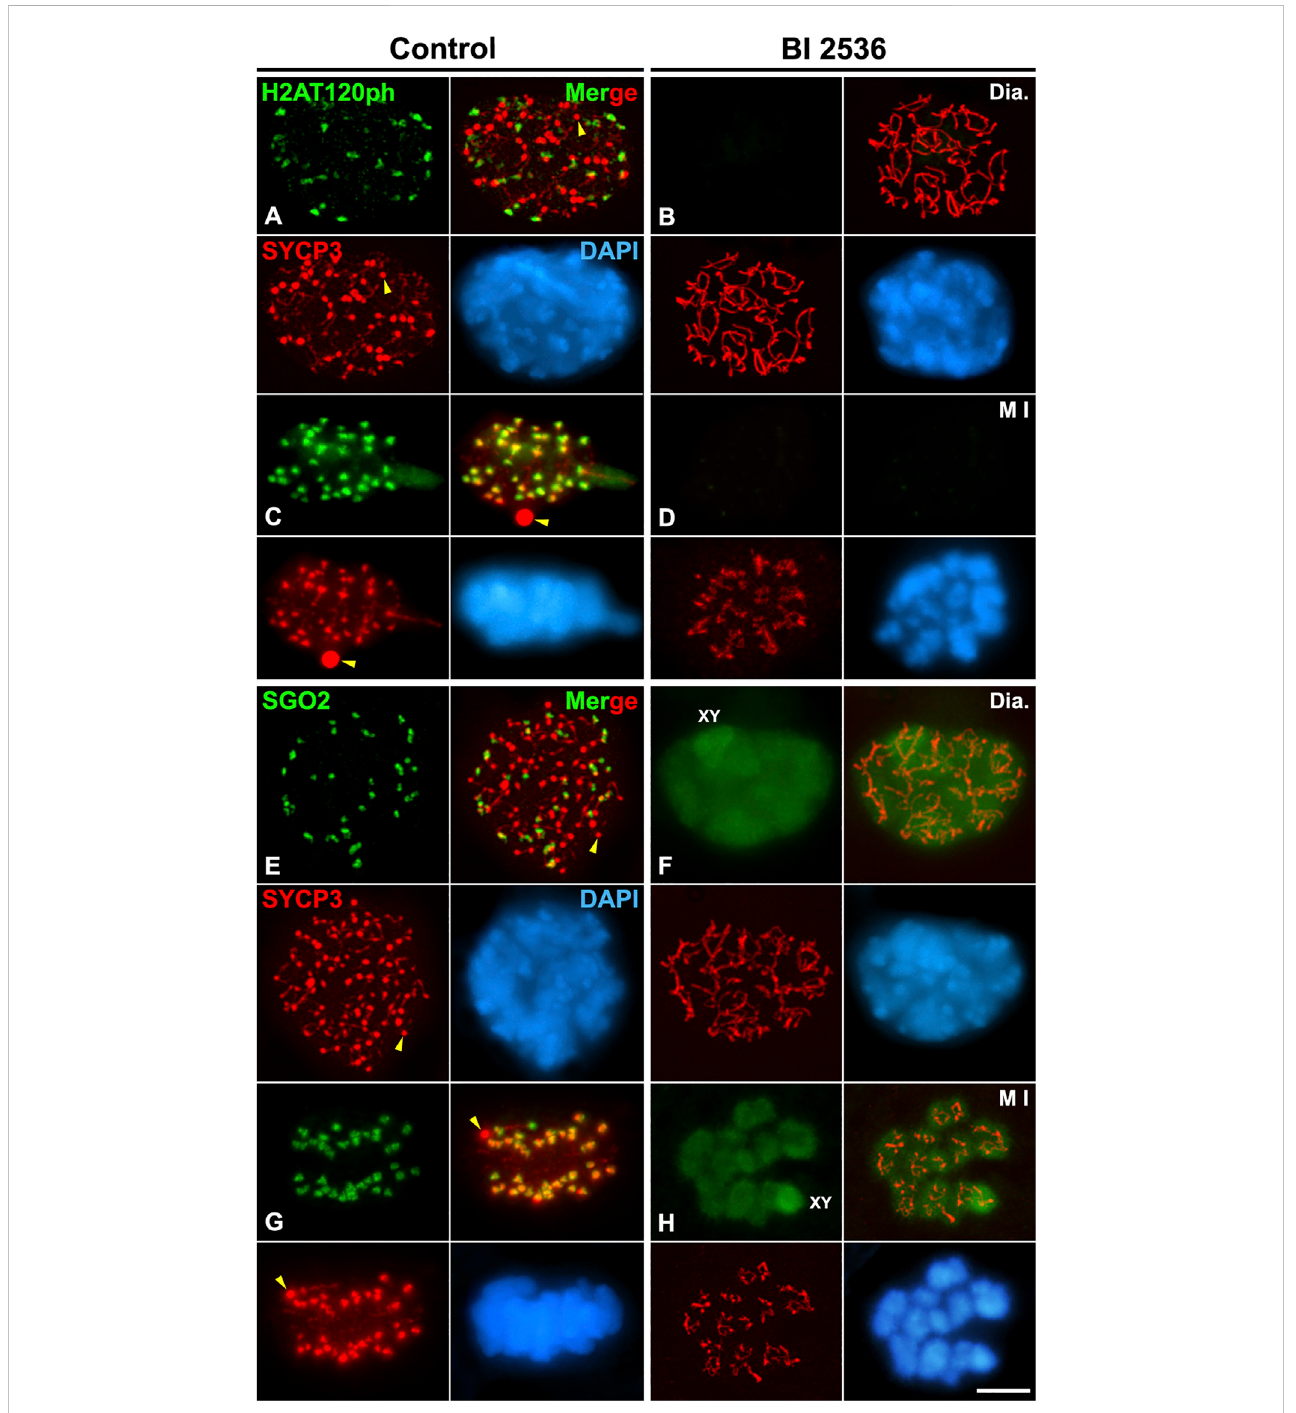
FIGURE 6 PLK1 regulates the H2AT120ph-dependent loading of SGO2 to the inner centromeres. Double immunolabelings of SYCP3 (red) with either H2AT120ph (green in A – D ), or SGO2 (green in E – H ), and counterstaining of the chromatin with DAPI (blue) on squashed diakinesis (Dia.) (A,E) and metaphase I (M I) (C,G) control spermatocytes, and diakinesis (B,F) and metaphase I (D,H) BI 2536-treated spermatocytes. The sex bivalent (XY) is indicated in (F,H) . Yellow arrowheads indicate SYCP3 agglomerates in the nucleoplasm and cytoplasm of control diakinesis and metaphase I spermatocytes, respectively. Scale bar represents 5 μ